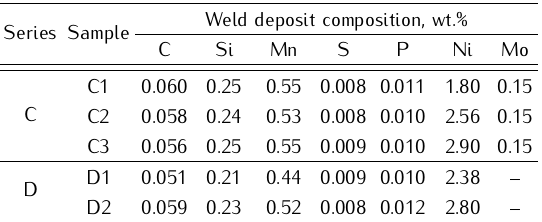
Table 4. Chemical composition of weld deposits of series C and D electrodes made with S1L cores. Weld deposit composition, Series Sample